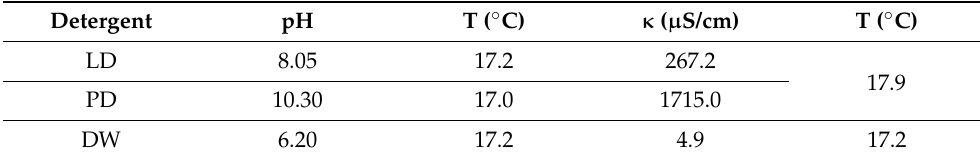
Table 2. pH and conductivity of detergent